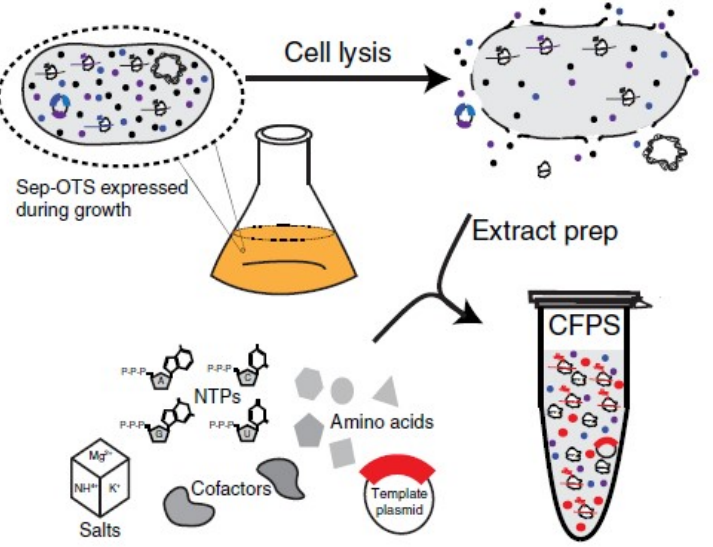
Figure 2. Phosphoprotein production by the combination of protein synthesis and a biotechnological approach: cell-free protein synthesis adapted for phosphoprotein biosynthesis in the presence of L-phosphoserine (Sep). The orthogonal translational system for phosphoprotein synthesis consists of phosphoseryl-tRNA synthetase, tRNASep, and the elongation factor. tRNASep is aminoacylated with Sep-Sep tRNA synthetase (SepRS). EF-Sep then delivers Sep-tRNASep to the ribosome. Reprinted with permission from [43]. Copyright 2015 Springer Nature.